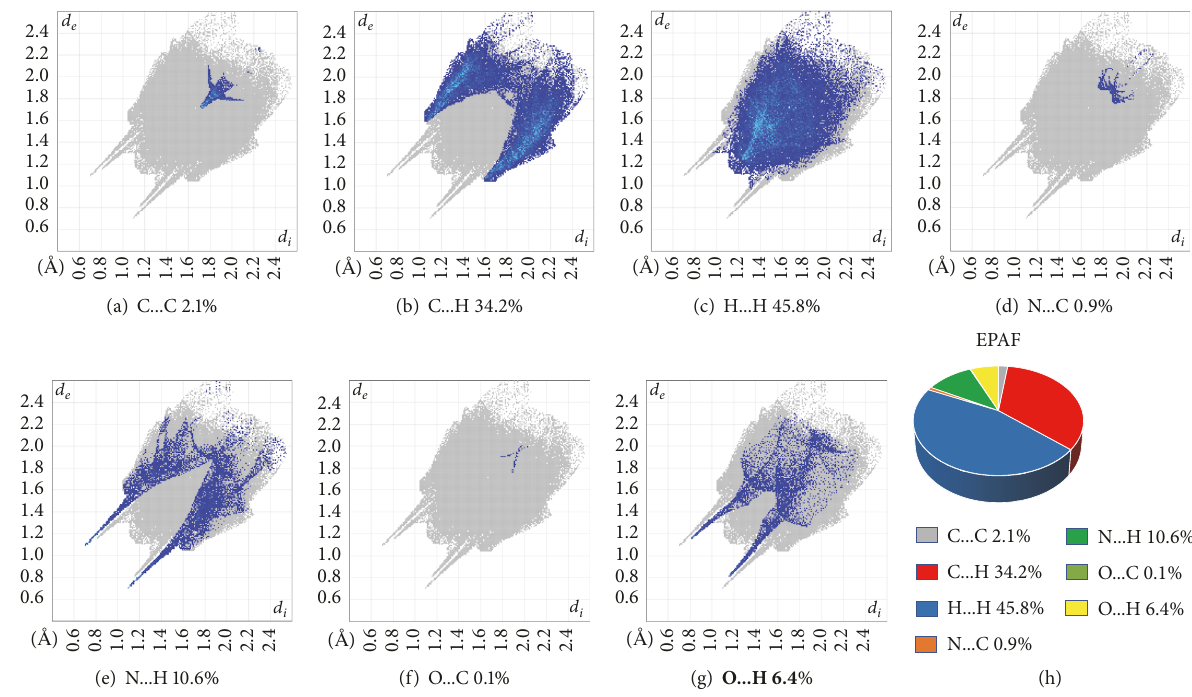
Figure 11: Fingerprint showing the 2D interactions of EPAF crystal.